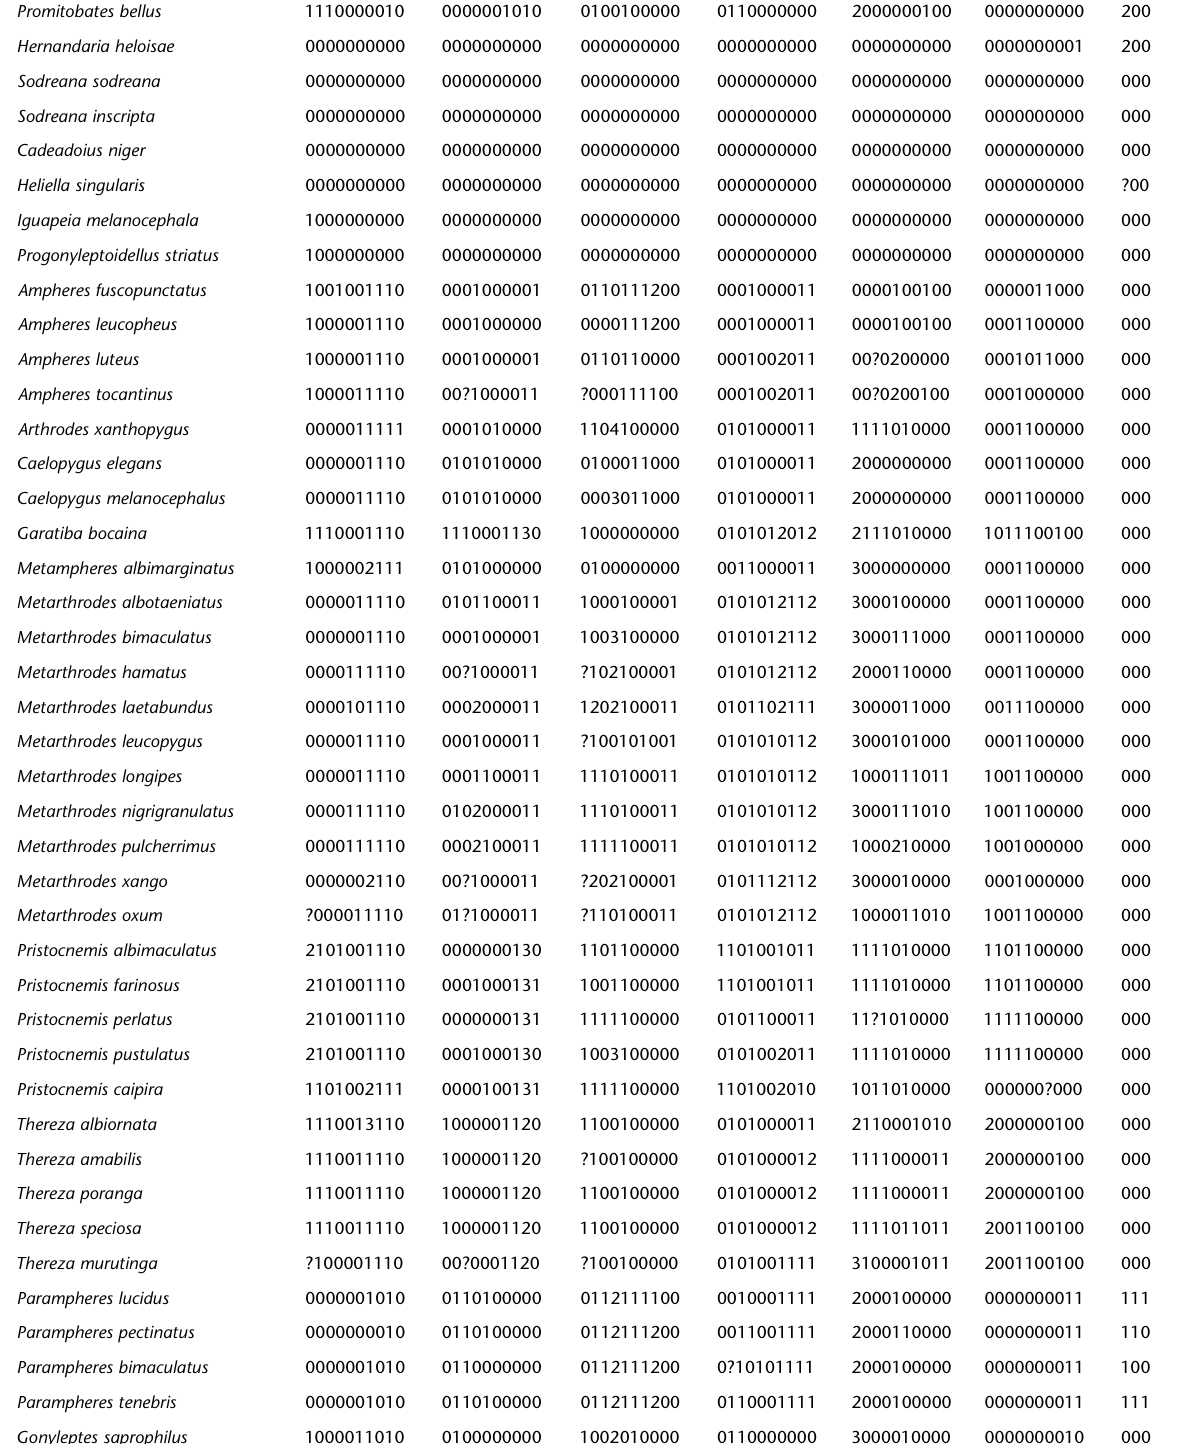
Table I. Data matrix for the species of Caelopyginae and